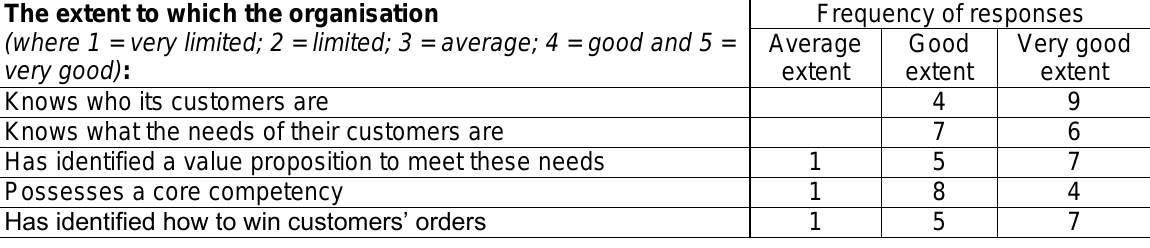
Table 1: Understanding customer needs and how to meet these needs ( n = 13) The extent to which the organisation